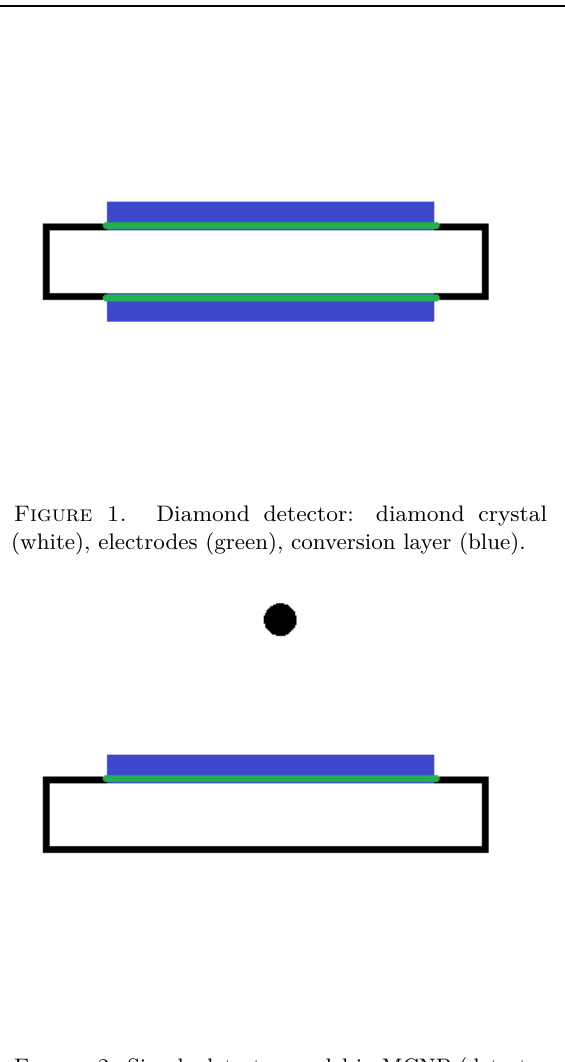
3.5 µm . Above this value, no more alpha particles are entering in the diamond crystal.